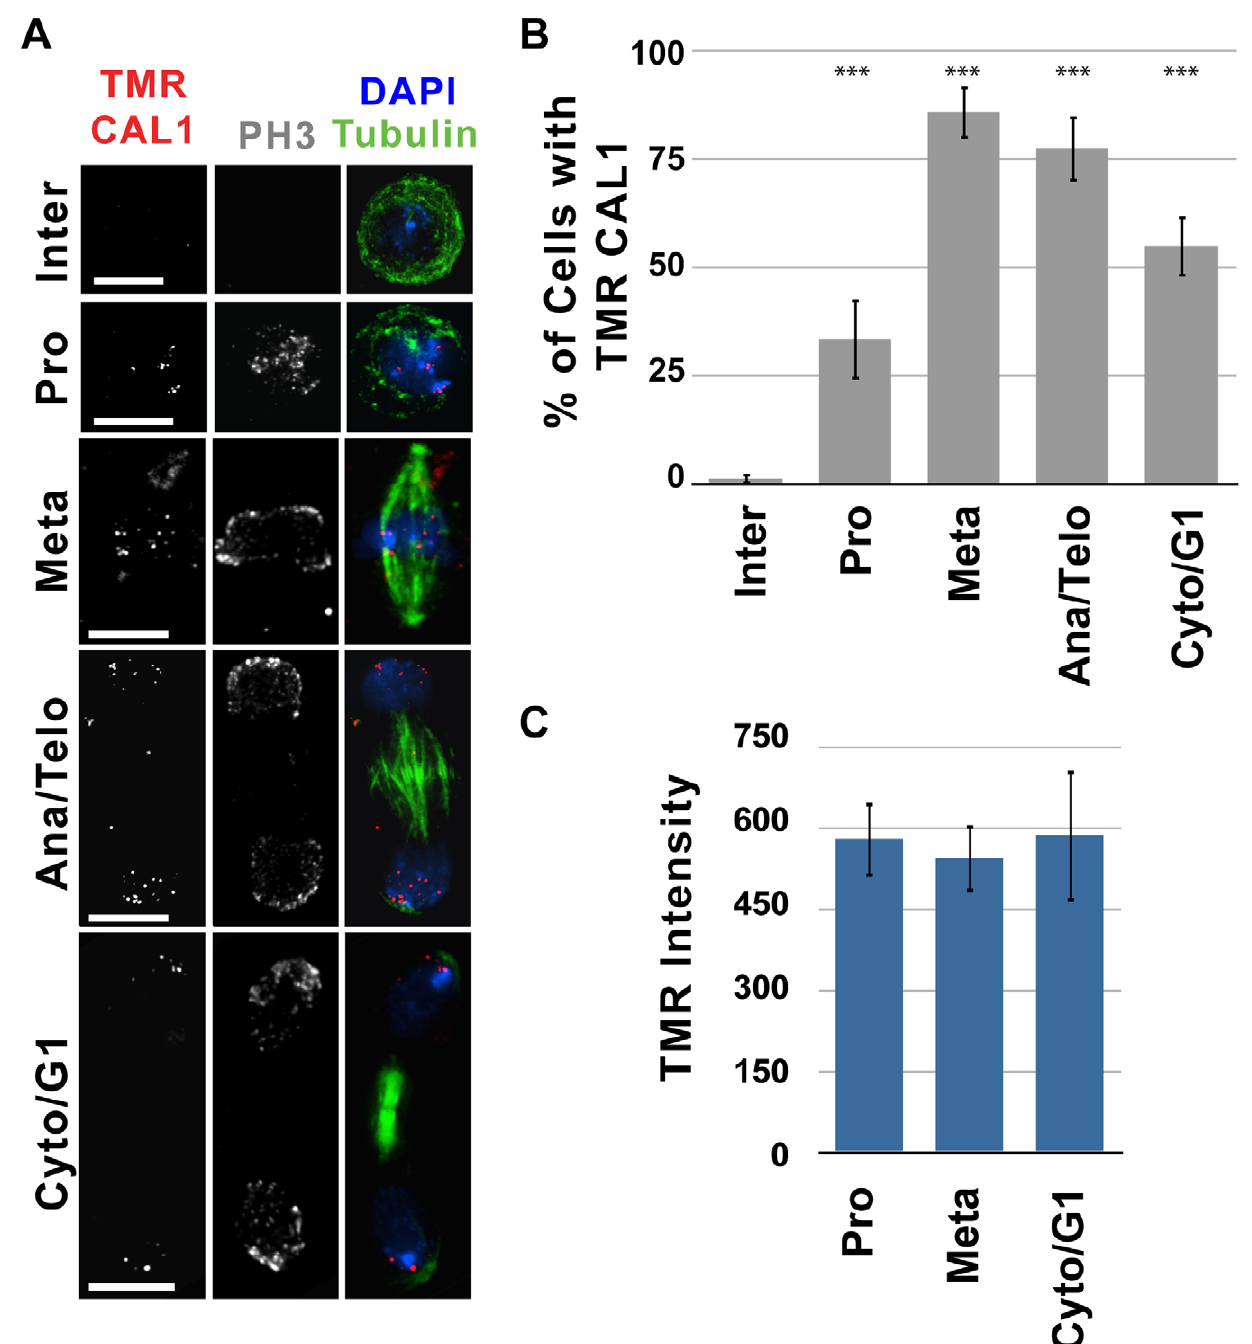
Figure 4. New CAL1 is first detectable during prophase in S2 cells. Quench-pulse-chase experiments were carried out as illustrated in Figure 2A. A) Representative images showing recruitment of newly-synthesized CAL1 (TMR, red) to centromeres 2 h after the BTP-block. TMR-CAL1 is absent in interphase (Inter), but is visible in prophase (Pro), anaphase/telophase (Ana/Telo) and cytokinesis/G1 (Cyto/G1). IF with anti-tubulin (green), anti-phospho H3 (gray), and DAPI (blue) was used to identify specific mitotic stages. Bar=5 m m. B) Average percent of interphase (n=84), prophase (n=27), metaphase (n=35), anaphase/telophase (n=31) cytokinesis/G1 (n=51) cells displaying centromeric TMR-CAL1 1 h following the BTP-block (X axis=cell cycle stage, Y axis=percent of cells positive for TMR labeling). New CAL1 recruitment is visible within the first hour following BTP-block in mitotic cells, and is first visible in prophase (*** p , 0.0001 compared to interphase, Fisher’s exact test). C) Quantitative comparison of the total TMR-CAL1 intensity at centromeres in prophase (n=13) metaphase (n=9) and cytokinesis, (n=12). TMR intensity did not change significantly with mitotic progression (p=0.9226, One-way ANOVA), suggesting that new CAL1 incorporation occurs mainly in prophase. Error bars represent standard error.